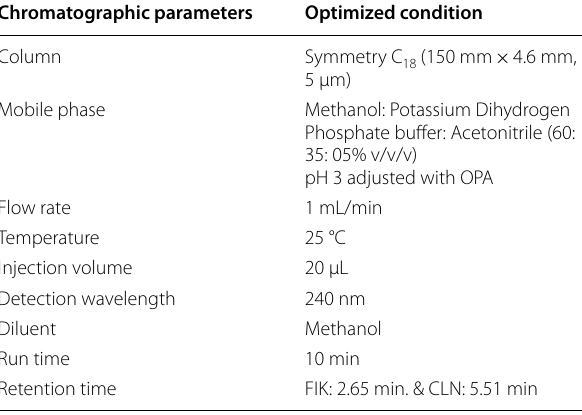
Table 1 Optimized chromatographic conditions Chromatographic parameters